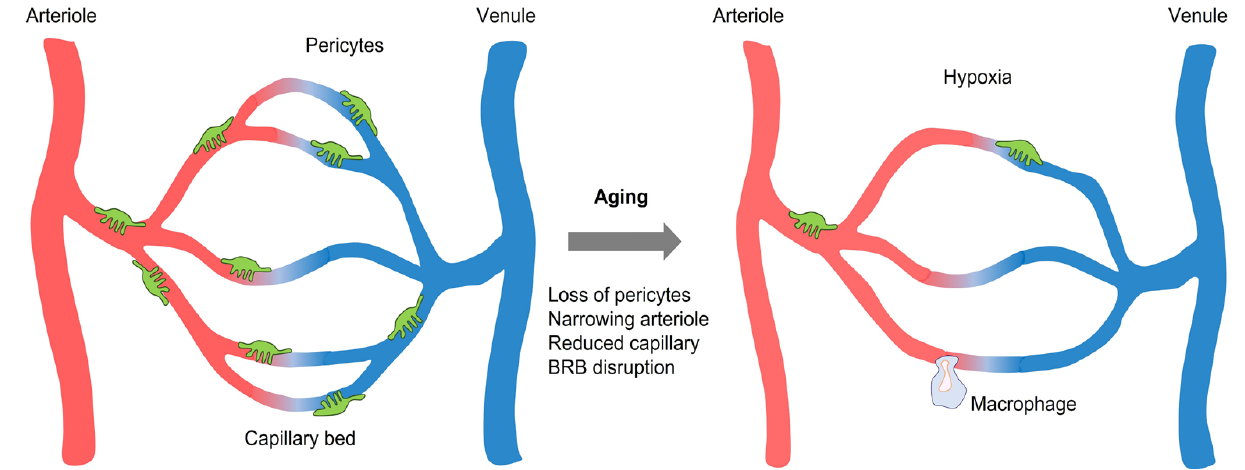
Figure 1. Comparison between the young and old vessels in the retina. Aging results in narrowing arteriole, retinal capillary degeneration, pericyte depletion, hypoxia, and BRB disruption. Abbreviation . BRB, blood-retinal barrier.